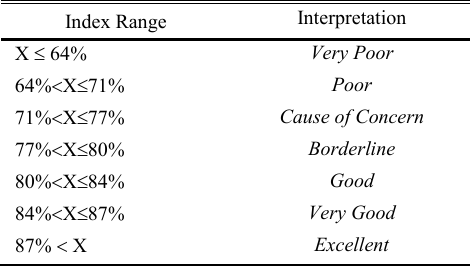
TABLE 1 C USTOMER S ATISFACTION I NDEX I